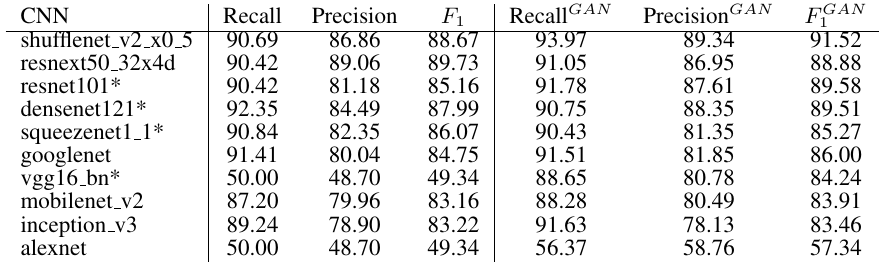
Table 2. Results of the patch classification experiment sorted by highest F 1 -score. All metrics are macro averaged (cmp. section 2.2). Hallermann, N., Morgenthal, G., 2014. Visual